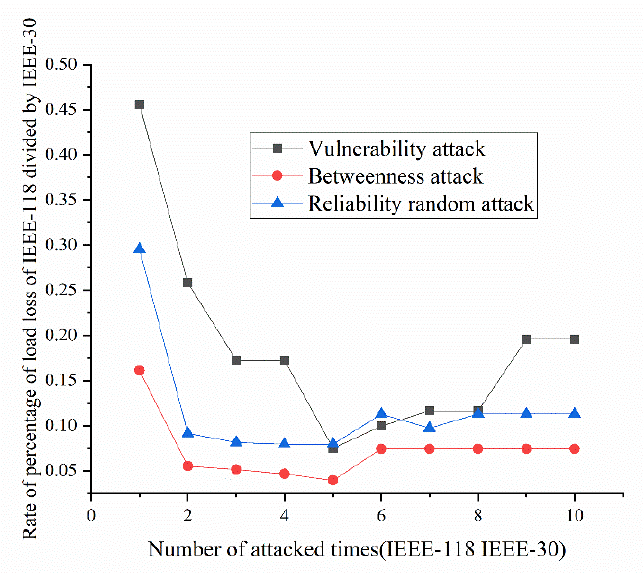
Figure 25. Rate of percentage of load loss under the three set attack modes.